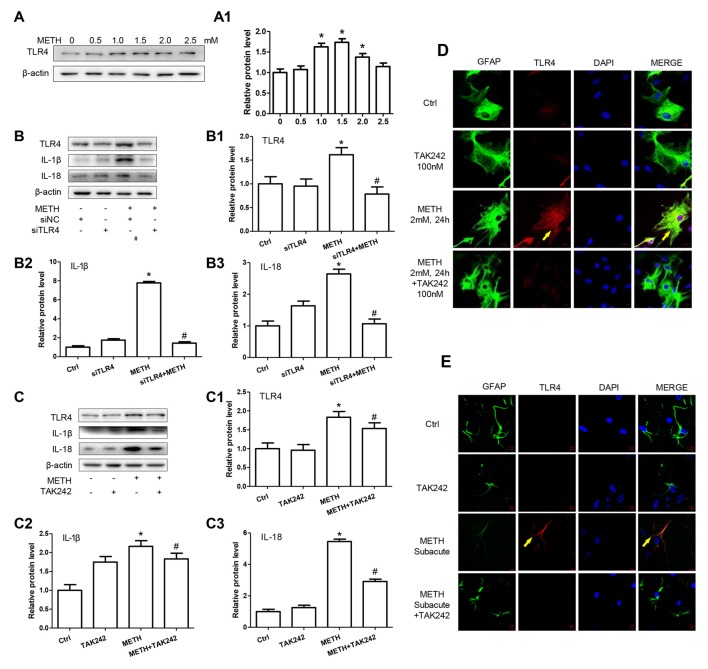
Toll-like receptor 4 (TLR4) is necessary for METH-induced IL-1β and IL-18 expression in astrocytes. (A,A1) Primary cultured astrocytes were exposed to 0.5, 1.0, 1.5, 2.0 and 2.5 mM METH for 24 h. (B–B3) Cells were transfected with siRNAs targeting TLR4 or control siRNA for 24 h followed by METH (2 mM) treatment for 24 h. (C–C3,D) Cells were exposed to TAK-242 (100 nM) for 2 h prior to METH (2 mM) treatment. Western blot (A–C) and quantitative analyses were performed to determine TLR4, IL-1β and IL-18 protein expression. Immunolabeling and confocal imaging analysis (D) showed elevated TLR4 expression in the cells treated with METH compared with controls. (E) Male C57BL/6 mice were divided randomly into control, METH, TAK-242 and METH + TAK-242 groups (n = 3/group). TAK-242 was injected intraperitoneally with DMSO and saline (3 mg/kg/injection, five injections, at 24 h intervals). At the 2nd day, animals were injected intraperitoneally with saline or METH (15 mg/kg/injection, eight injections, at 12 h intervals). Midbrain tissues were harvested at 2 h after the last dosing. Immunolabeling and confocal imaging analysis showed elevated TLR4 expression in the midbrain of METH-exposed mice compared with controls. Yellow arrow refers to TLR4. Cell experiments were repeated three times. Data are expressed as mean ± SD. *p < 0.05 vs. non-METH-treated group. #p < 0.05 vs. the scrambled + METH treated group. Data in (A) were analyzed with one-way ANOVA followed by LSD post hoc analyses; data in (B,C) were analyzed with 2 × 2 factorial ANOVA followed by LSD post hoc analyses.